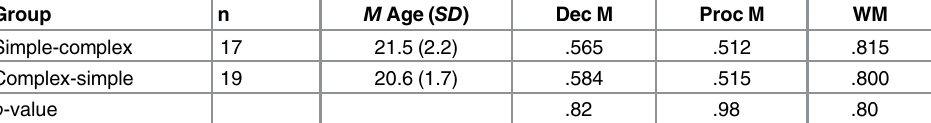
Table 5. Group sizes, mean ages, and measures of memory subsystems for Simple-complex and Complex-simple training order groups in Experiment 3. Bottom row shows p-values from t-tests confirm- ing that the groups were matched on each memory